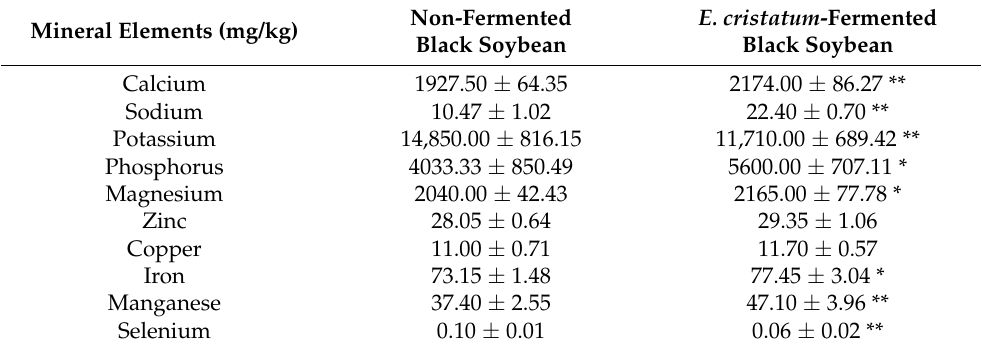
Table 3. Mineral elements content of E. cristatum -fermented and non-fermented black soybeans. Mineral Elements (mg/kg)